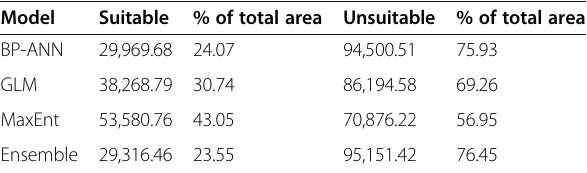
Table 6 Area (km 2 ) and percent of different classes of habitat suitability for Amygdalus scoparia in Fars Province, southern Iran Model